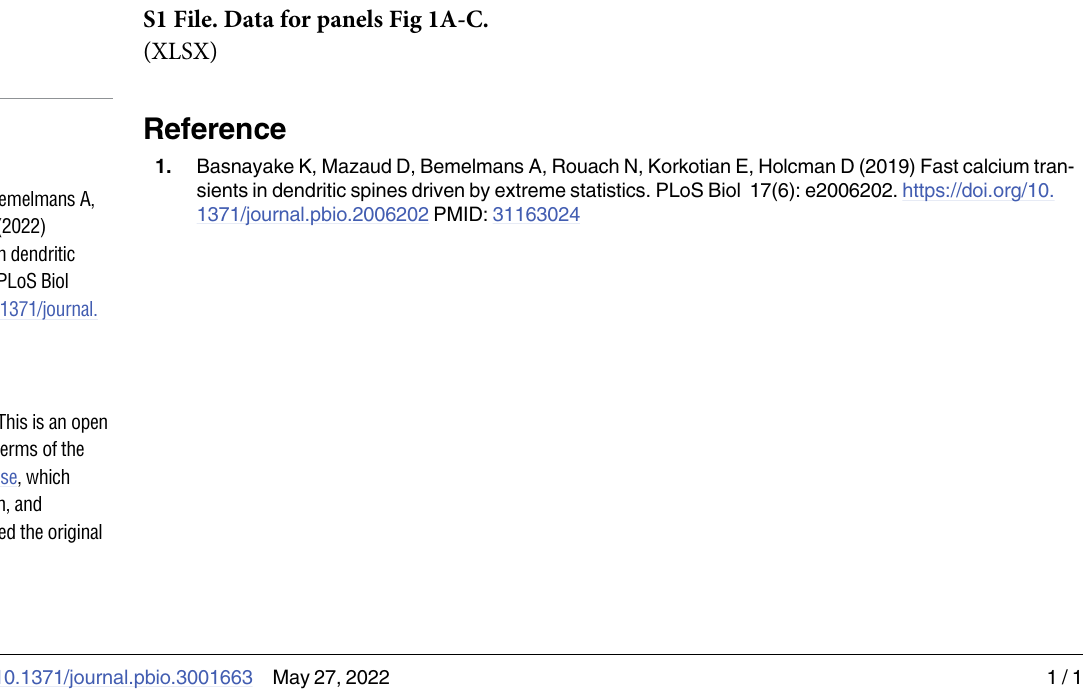
S1 File. Data for panels Fig